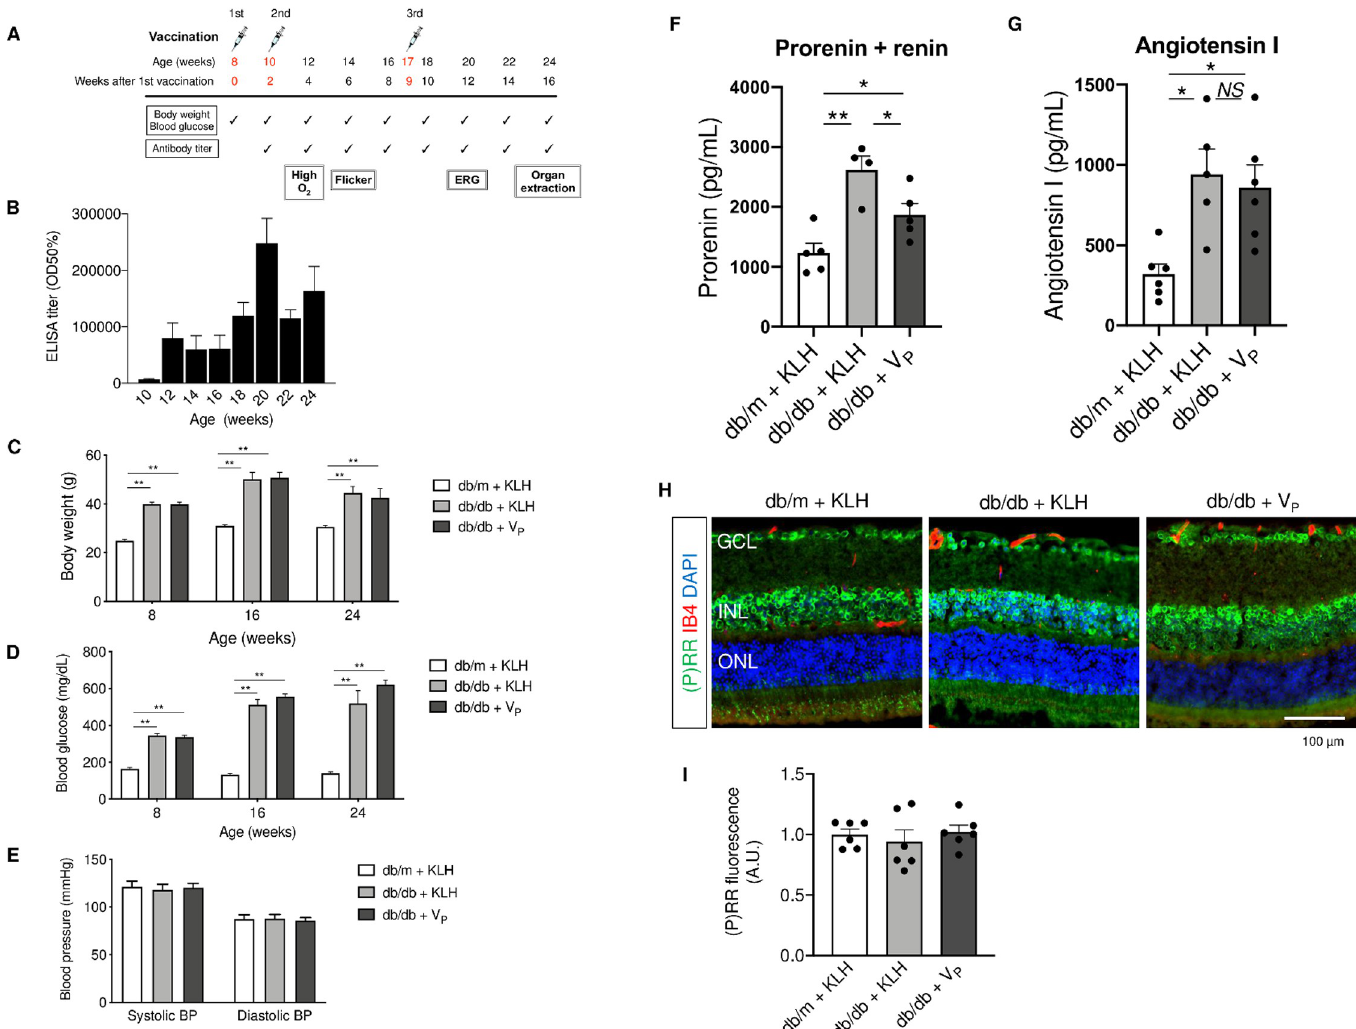
Fig 3. Immunization with a prorenin peptide vaccine. (A) Vaccination schedule and experimental plan in diabetic db/db and non-diabetic control db/m mice. The body weight and blood glucose levels were monitored every 2 weeks. Antibody titer measurement was started from 2 weeks after the first vaccination and continued every 2 weeks. Hyperoxia (“High O 2 ” in the figure), flicker light stimulation (“Flicker”), and electroretinography (“ERG”) were performed at 12, 14, and 20 weeks of age, respectively, and eyeballs were surgically removed (“Organ extraction”) at week 24. (B) Antibody titer (mean ± SE) in db/db + V P mice. (C) Body weight (mean ± SE) in each group at 8, 16, and 24 weeks of age. (D) Blood glucose levels (mean ± SE) in each group at 8, 16, and 24 weeks of age. (E) Blood pressure (mean ± SE) in each group 16 weeks after the first vaccination. (F) Prorenin plus renin concentration in the blood at 24 weeks of age. (G) Angiotensin I concentration in the blood at 24 weeks of age. (H) and (I) Expression of (pro)renin receptor [(P)RR] (green) in the retina at 24 weeks of age. Retinal vessels (red) were visualized by IB4. BP, blood pressure; DAPI, 4 0 ,6-diamidino-2-phenylindole; ELISA, enzyme-linked immunosorbent assay; GCL, ganglion cell layer; IB4, isolectin B4; INL, inner nuclear layer; KLH, keyhole limpet hemocyanin; ONL, outer nuclear layer; P(RR), (pro)renin receptor; V P , prorenin peptide vaccine. Scale bar = 100 μ m. � p < 0.05, �� p < 0.01, NS = not significant. N = 6 in each group except for the measurement of the prorenin plus renin and angiotensin I